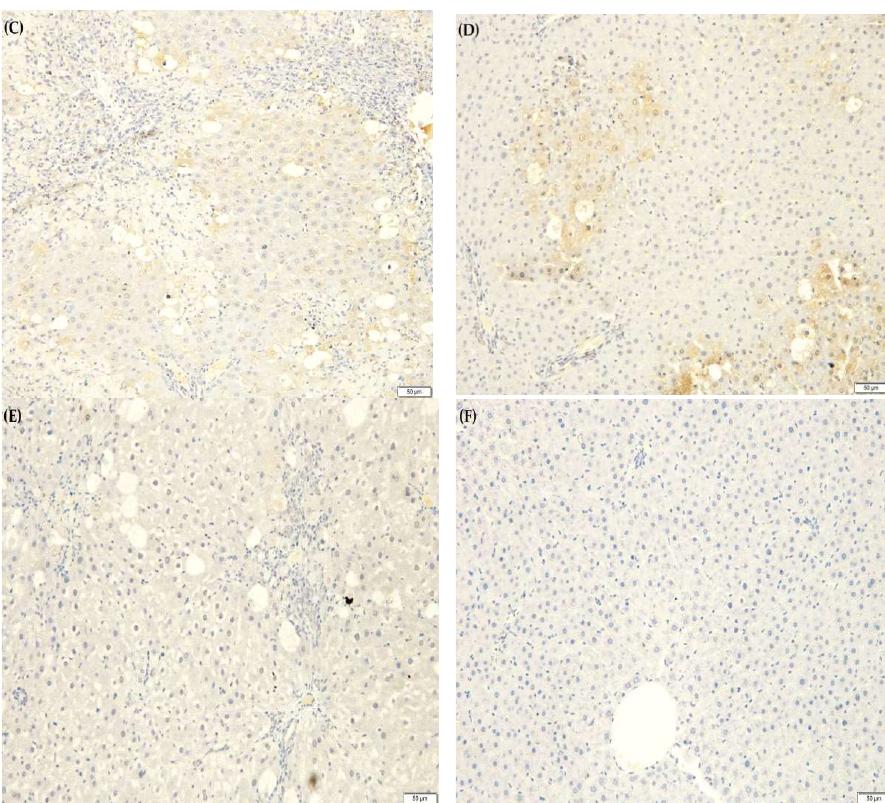
Figure 5. The effect of F. lepicarpa extract on the proinflammatory marker prostaglandin E 2 (PGE 2 ). Total magnifications 10×. ( A ) Control group, normal. ( B ) CCl 4 (1.0 mL/kg bwt), high expression of PGE 2 . ( C ) F. lepicarpa (100 mg/kg bwt + CCl 4 ), low expression of PGE 2 . ( D ) F. lepicarpa (200 mg/kg bwt + CCl 4 ), low expression of PGE 2 . ( E ) F. lepicarpa (400 mg/kg bwt + CCl 4 ), low expression of PGE 2 . ( F ) F. lepicarpa (400 mg/kg bwt, plant control), normal.